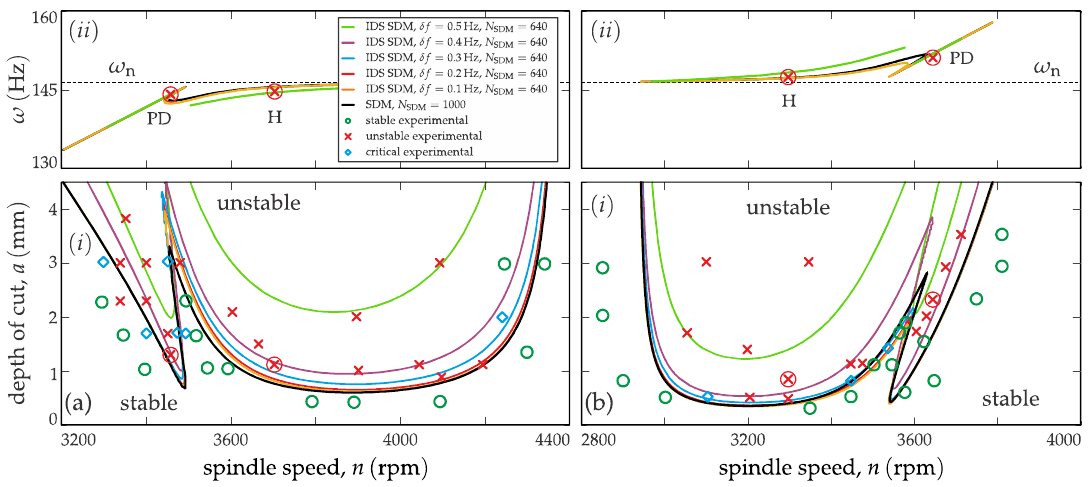
Figure 4. Comparison calculations are presented for DM and UM cases in panels ( a , b ). The SLDs and their corresponding vibration frequency charts are shown in panels (i,ii). The exact conventional SDM calculations (black line) are compared to the ones of IDS SDM. The experimental data was taken from the work in